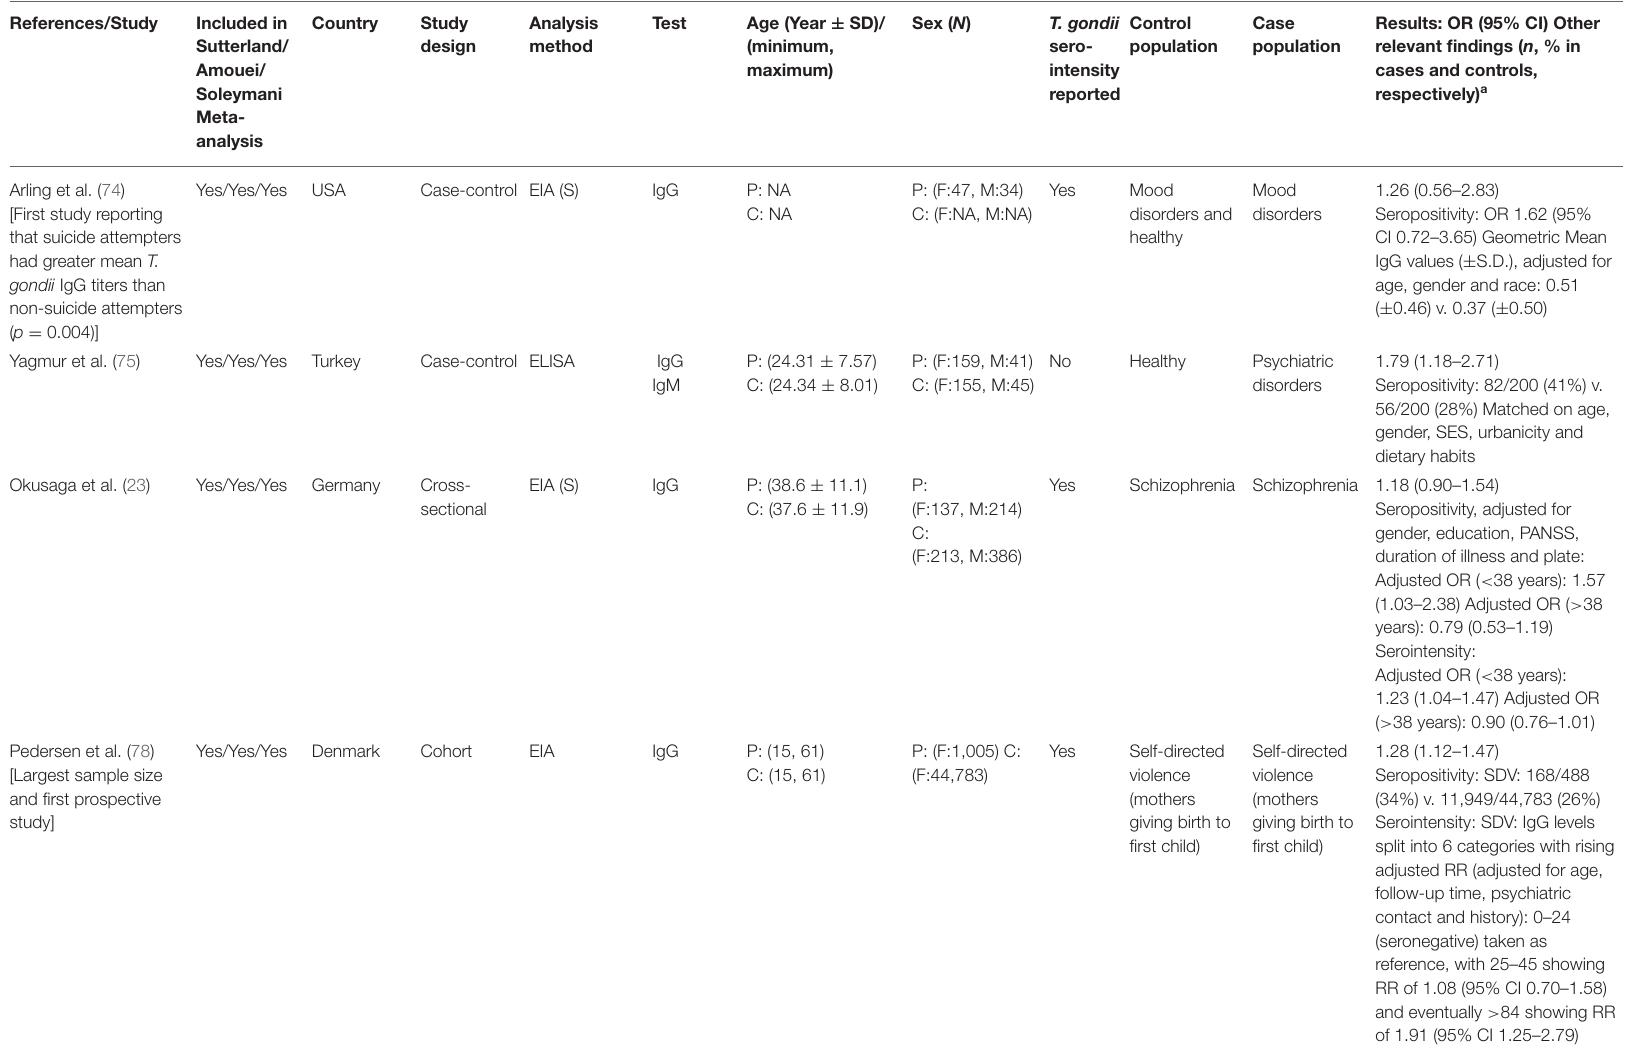
TABLE 1 | Individual studies used in the three meta-analyses with suicide attempts as the outcome measure presented in the article. References/Study